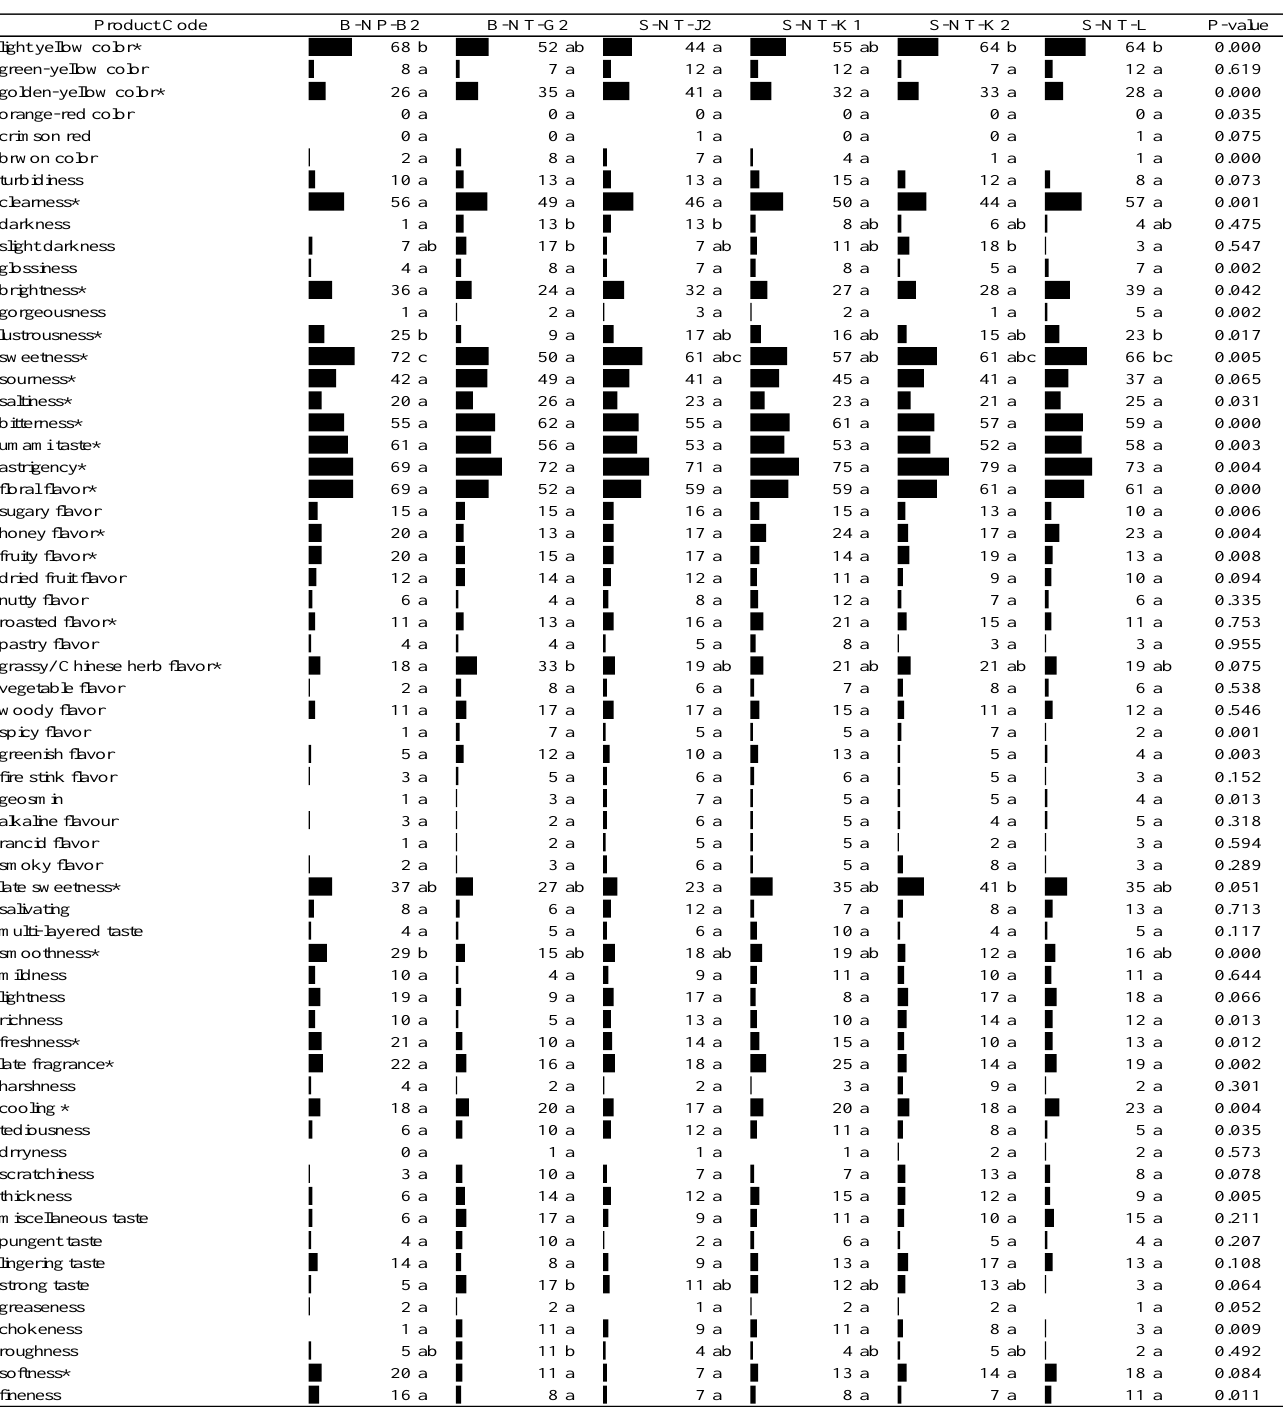
Figure 3. Participants’ selection frequencies of association for the cold infusions of the second round of Taiwanese GABA Oolong tea made by the TTES #12 based on the CATA method (n = 100). Significant difference ( p < 0.05) of panelists’ selection proportions for each attribute among the six tea samples were determined by Cochran’s Q test. The pairwise post-hoc McNemar test (Bonferroni) was also performed, and the tea samples signed with different alphabet letters were significantly different in the frequencies of panelists’ selection for the attribute listed on the same row. Asterisks are marked on the attributes selected by more than 20% of